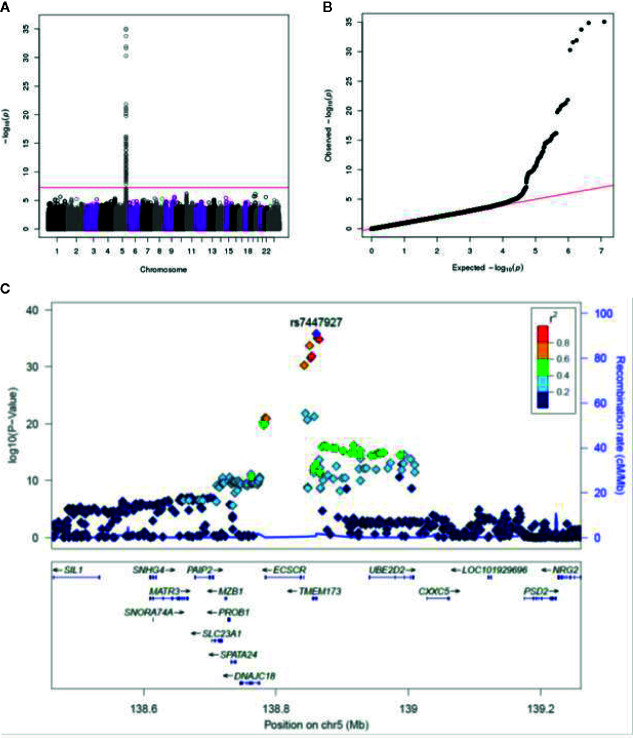
GWAS genotyping results in the combined smallpox vaccine recipient cohort. (A) Manhattan plot indicating SNPs associated with IFNα response. (B) QQ plot of genome-wide p-values. (C) Locus-zoom plot depicting region on chromosome 5 with the strongest association signal. SNP LD is shown in color. The name and location of each gene is shown at the bottom of the panel.